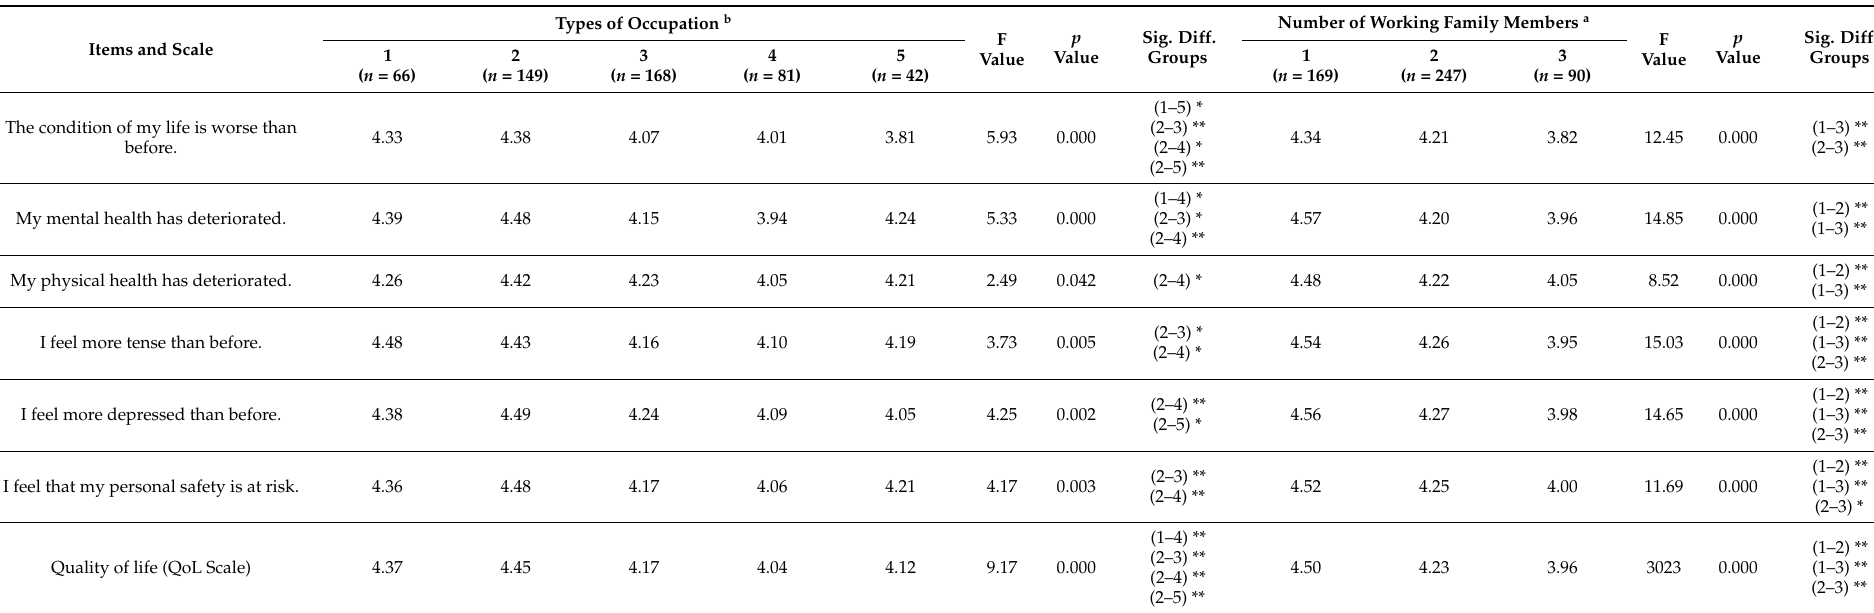
Table 5. ANOVA for mean scores of respondents on QoL items and QoL scale classified by number of working family members and types of occupation. Items and